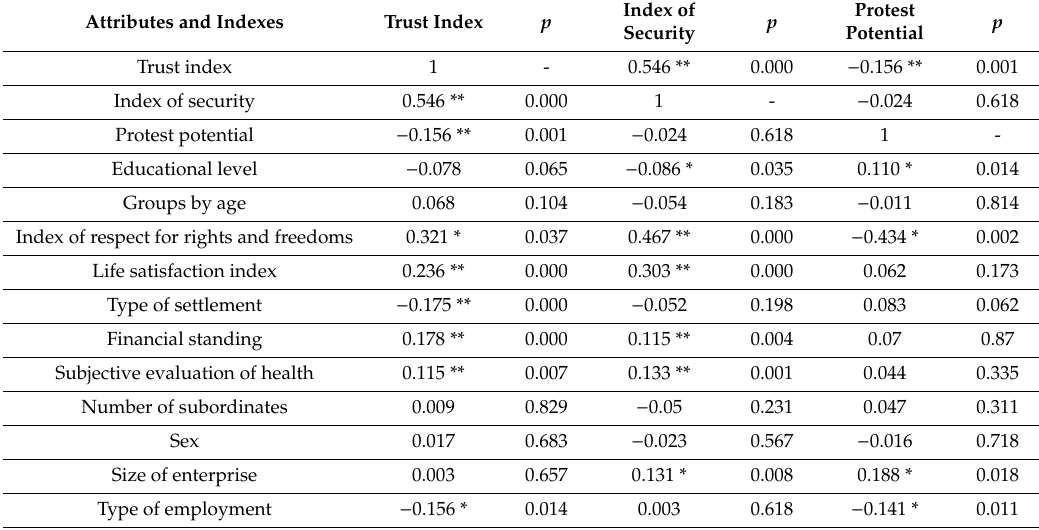
Table 2. Fragment of the table of correlation coe ffi cients (Spearman’s rho) and the significance of the relationship of the main features of the